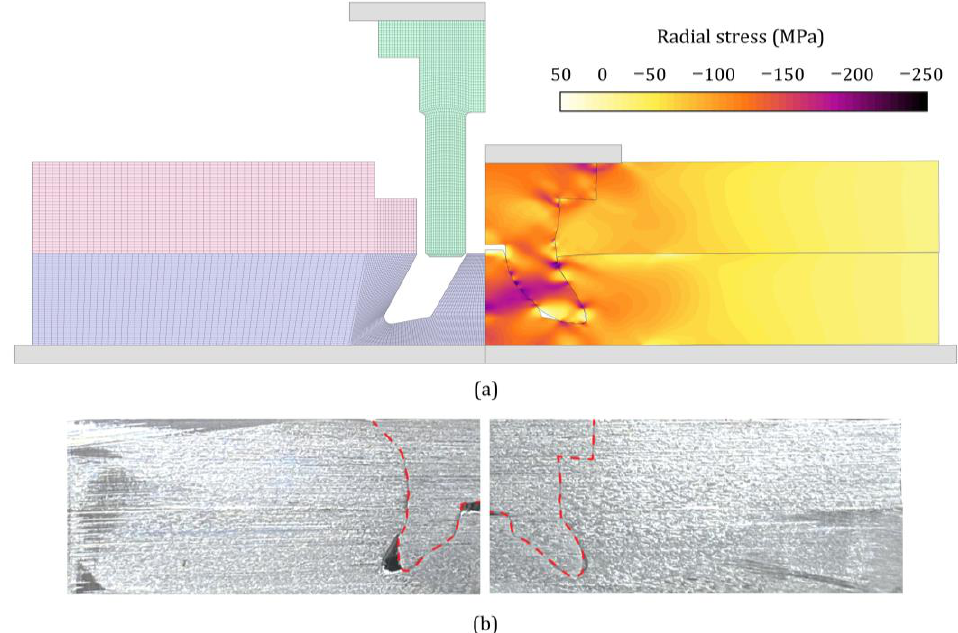
Figure 8. Finite element simulation of injection lap riveting counterbored head rivets showing ( a ) the mesh at the beginning (left) and the distribution of radial contact pressure (MPa) at the end of stroke (right) for unit cells with 𝛼 = 30°, 𝑑 𝑝 = 4 mm and ( b ) a photograph of a cross-section where the counterbored head rivet (right) is compared with that obtained using a countersunk geometry (left).